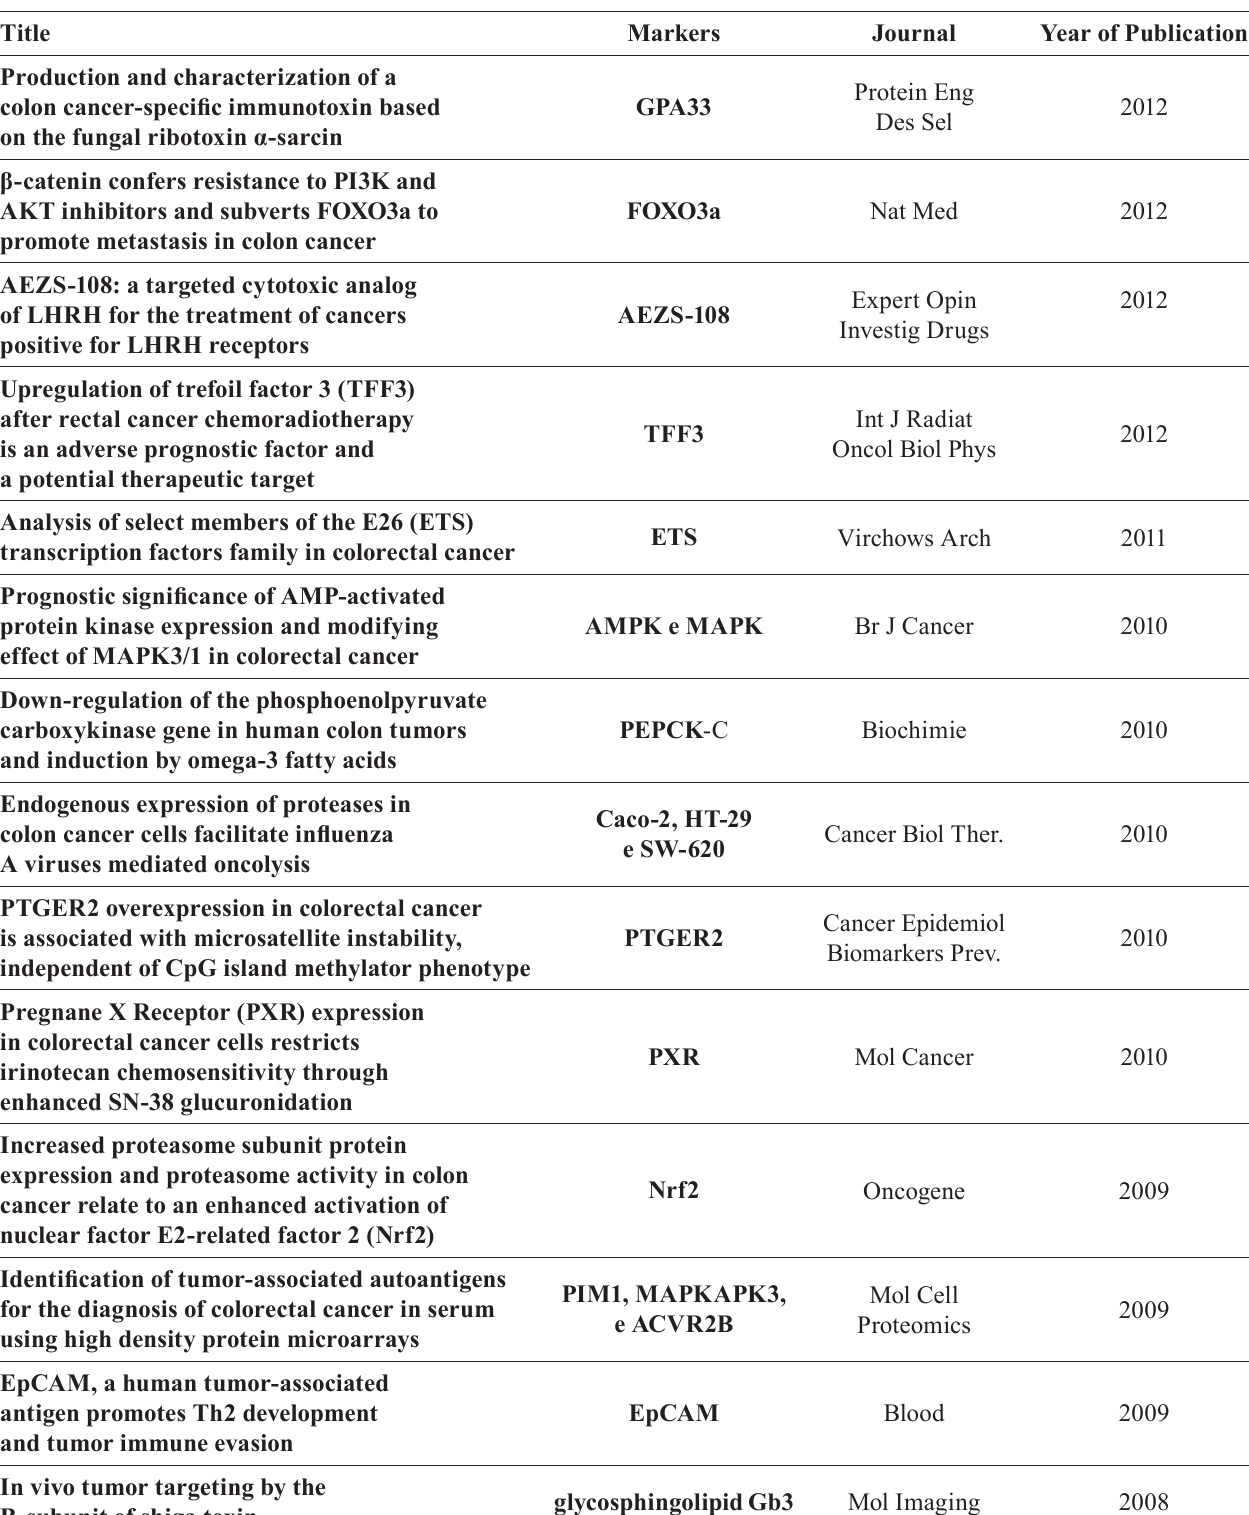
TABLE I - T umor targets of CRC identified in articles searched in PubMed, with their respective journals and year of publication